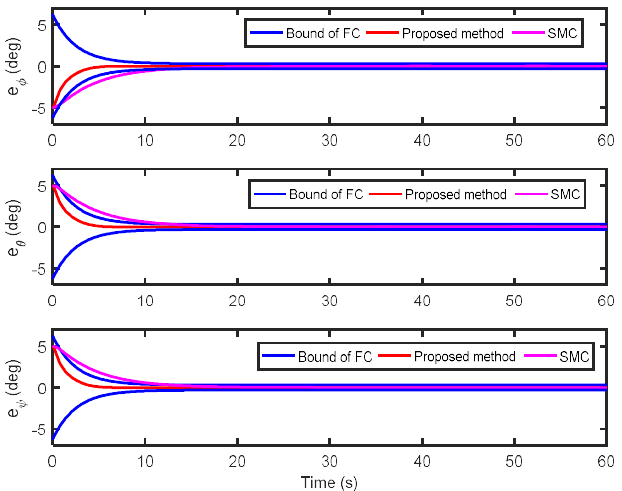
Figure 7. Comparisons of angle tracking errors between FC and SMC. Table 4. Contrastive outcomes between proposed method and SMC [33] in